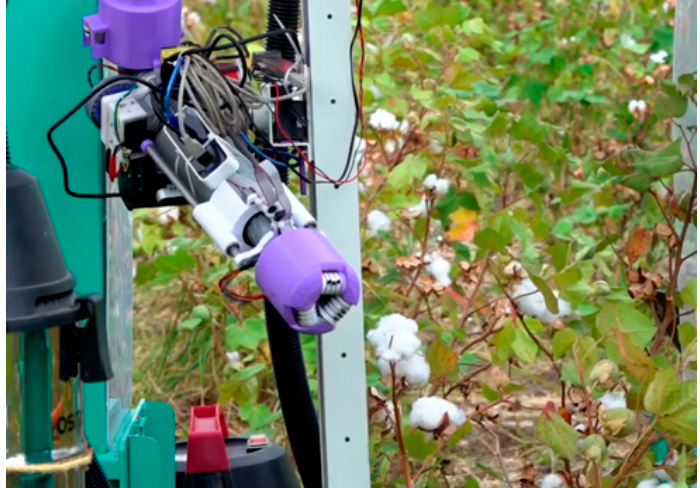
Figure 9. Green Robot Machinery (gRoboMac) manipulator trying to get the cotton boll (source: www.grobomac.com).